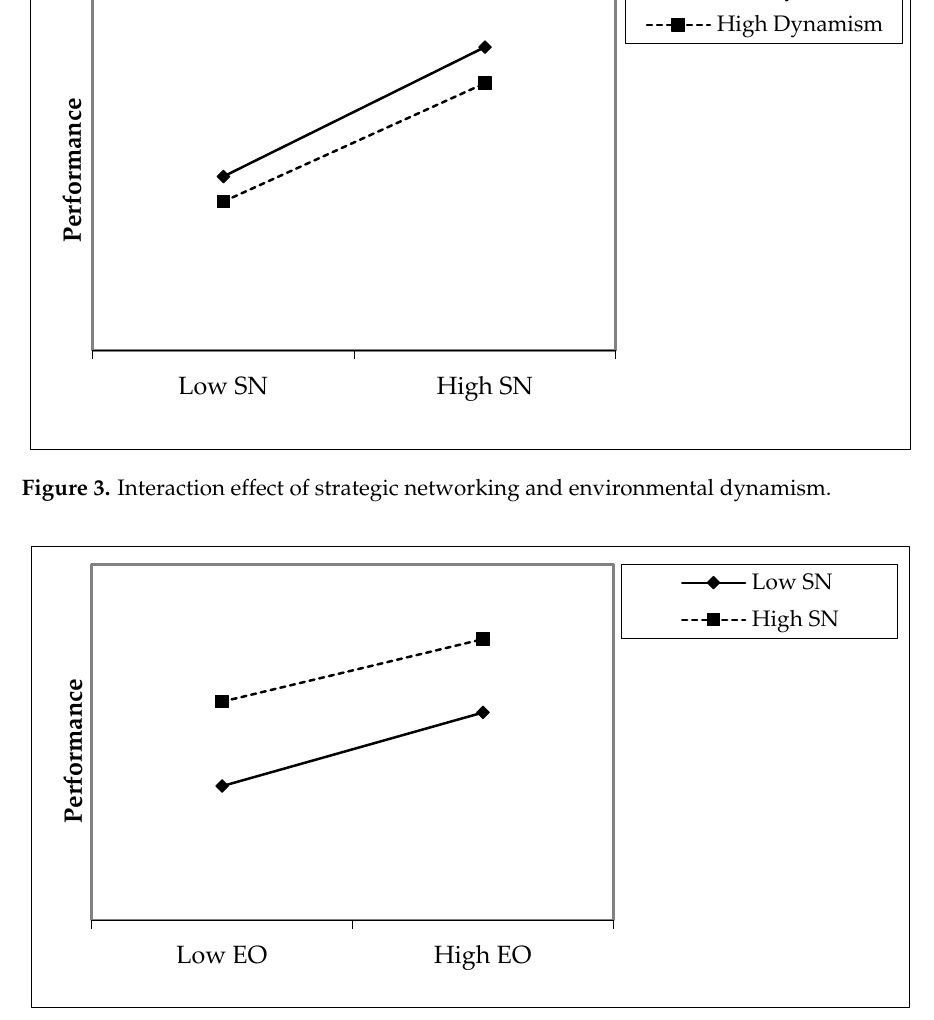
Figure 4. Interaction effect of entrepreneurial orientation and strategic